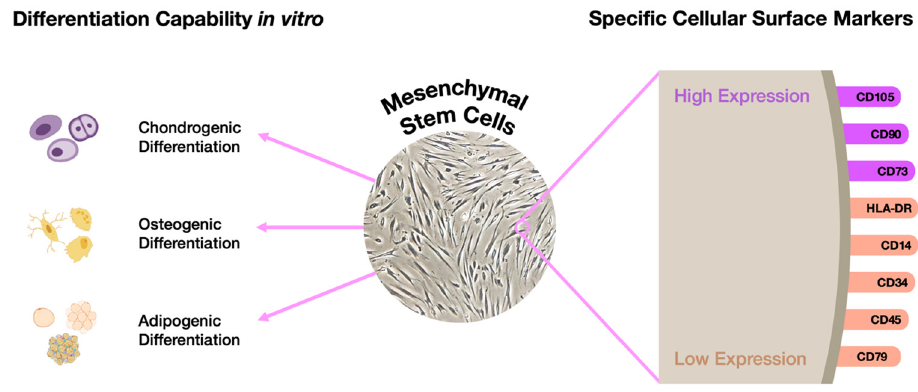
Figure 4. Minimal requirements for identi fi cation of mesenchymal stem cells (MSCs).